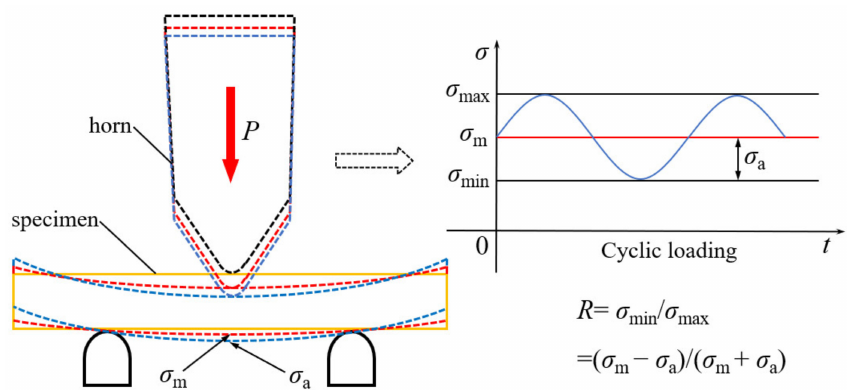
Figure 5. Schematic diagram of three-point bending loading